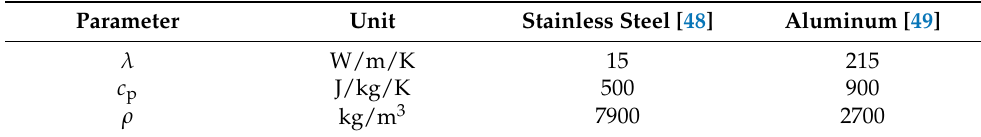
Table 8. Properties of the investigated